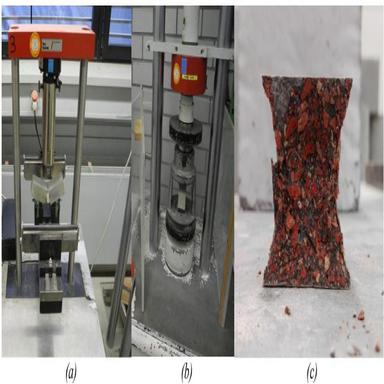
(a) 3-point bending test, (b) compressive strength test and (c) a PCM-RBA-mortar sample after the compressive strength test.